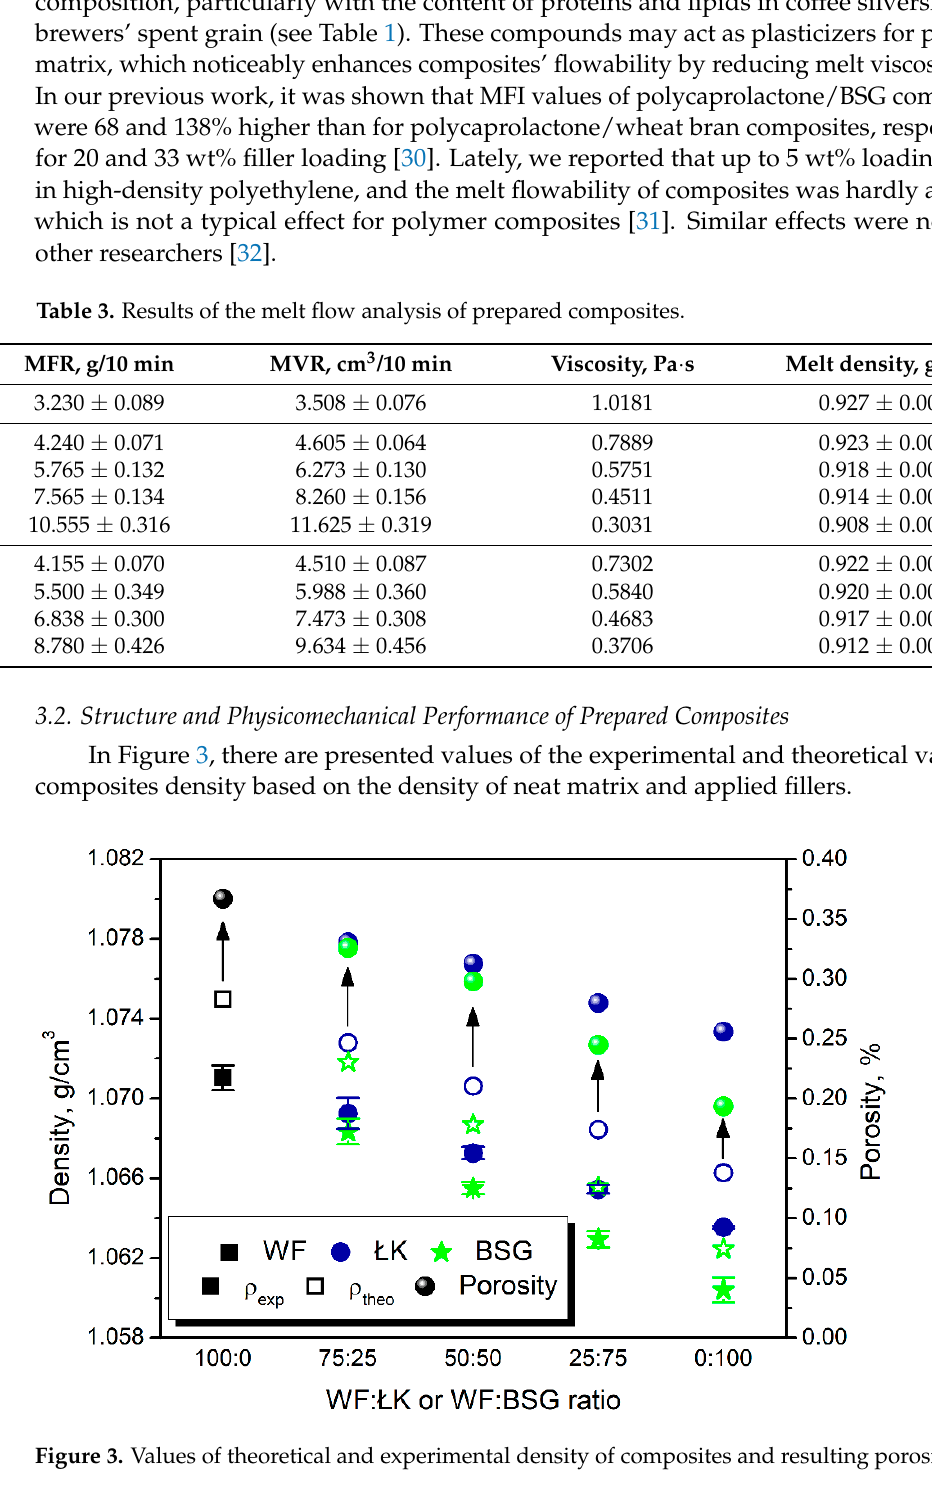
Table 3. Results of the melt flow analysis of prepared composites.